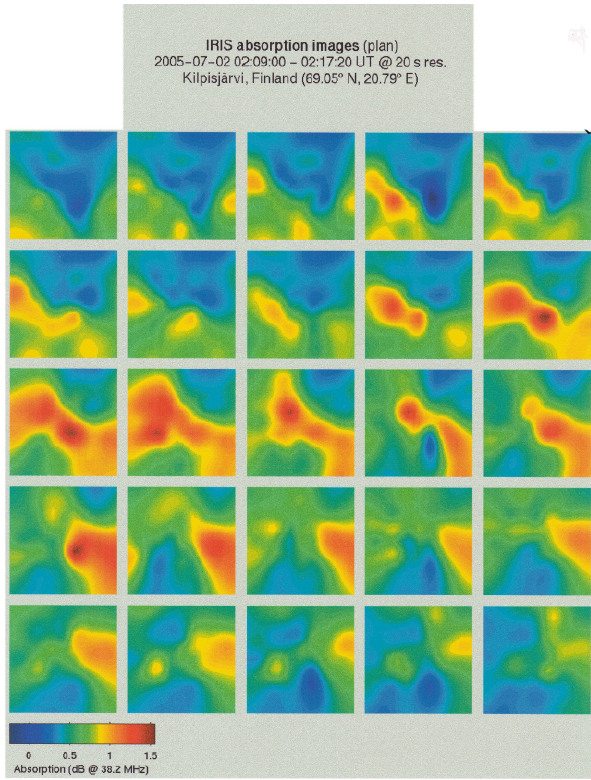
Fig. 12. As Fig. 11, but for the period 02:09:00 to 02:17:20 UT.